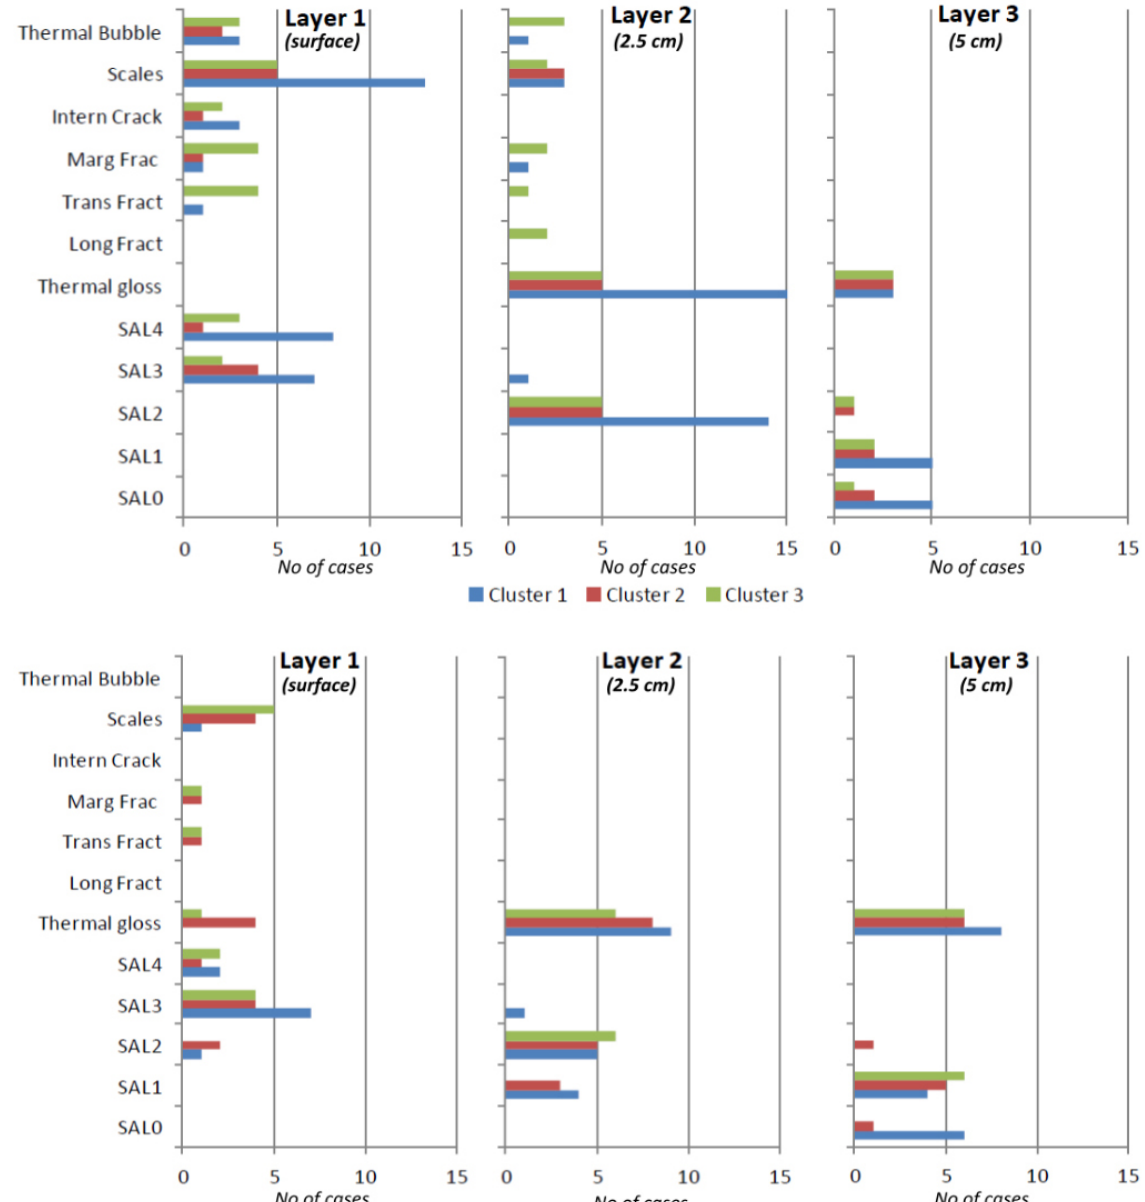
Figure 9. Presence or absence case table of SAL and heat alteration features for Bergerac flint blanks (above) SMM flint blanks (below). Results are shown according to volume cluster for each of the layers (note that cluster 3 also includes cluster